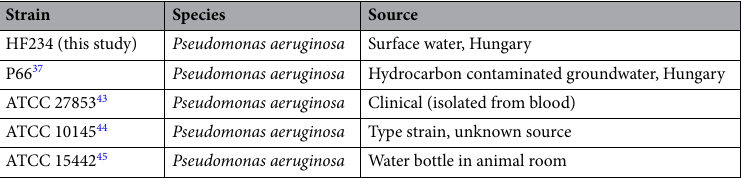
Table 1. P. aeruginosa strains used in this